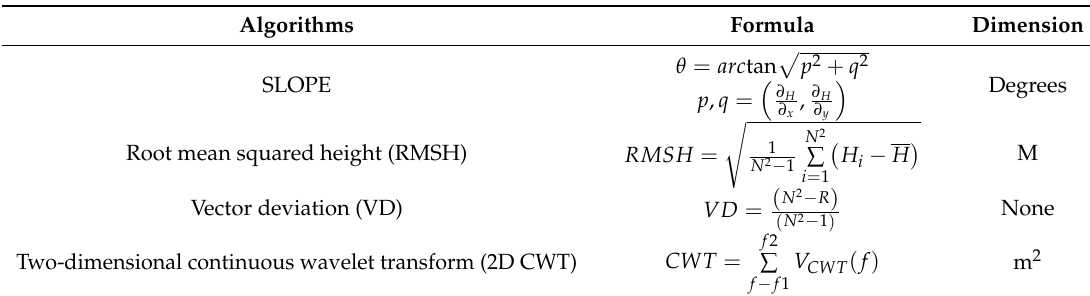
Table 1. Algorithms of